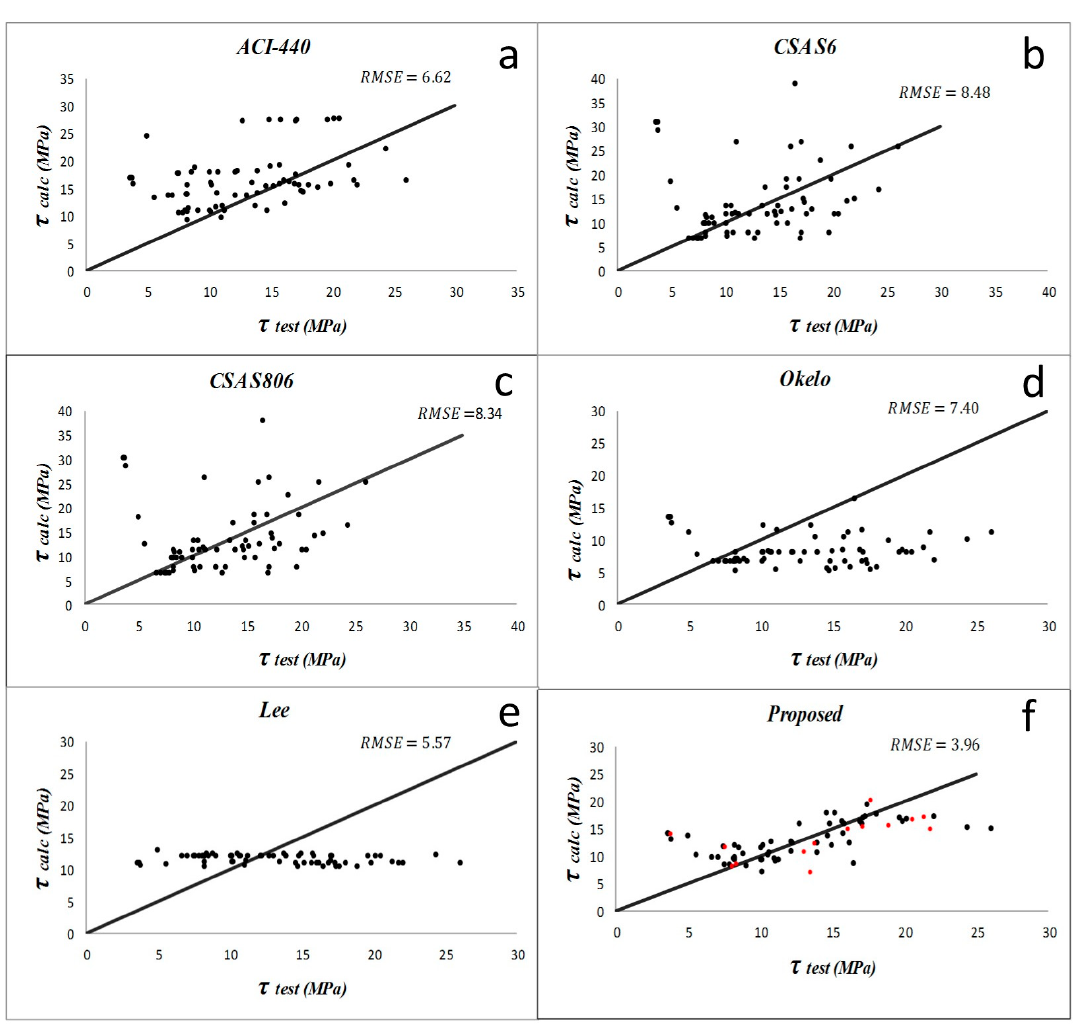
Figure 8. Bond strength prediction results by different models ( a – f ) on the concrete with the concrete high strength sand-coated FRP bars (study group 4). The data used for validation are shown as red points in figure ( f ).